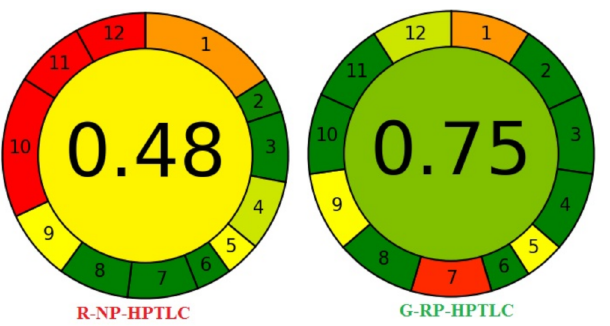
Figure 4. Greener images for analytical GREEnness (AGREE) scales for R-NP-HPTLC and G-RP- HPTLC methods obtained using AGREE: The Analytical Greenness